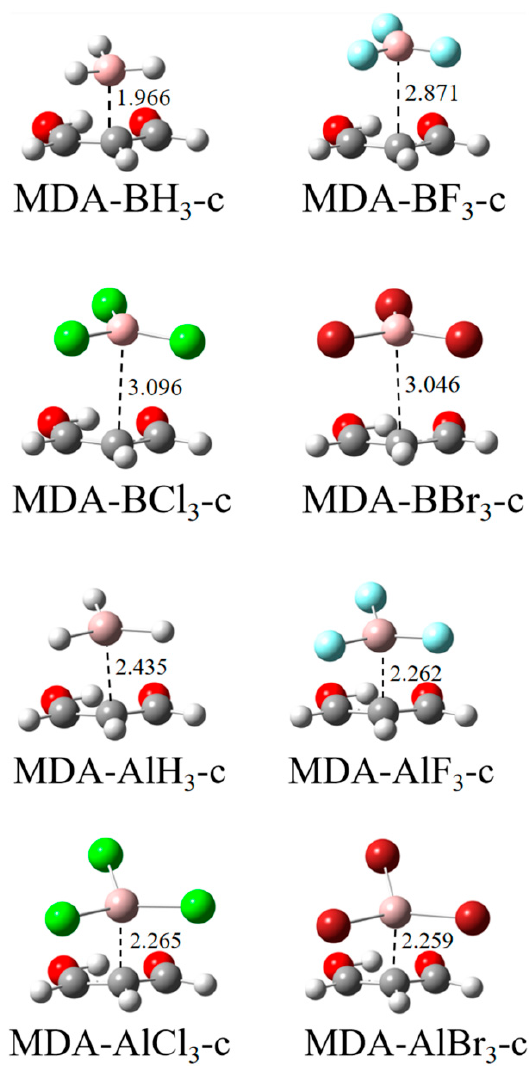
Figure 4. The π – π structures formed by the central carbon of MDA with TrX 3 . Distances are in